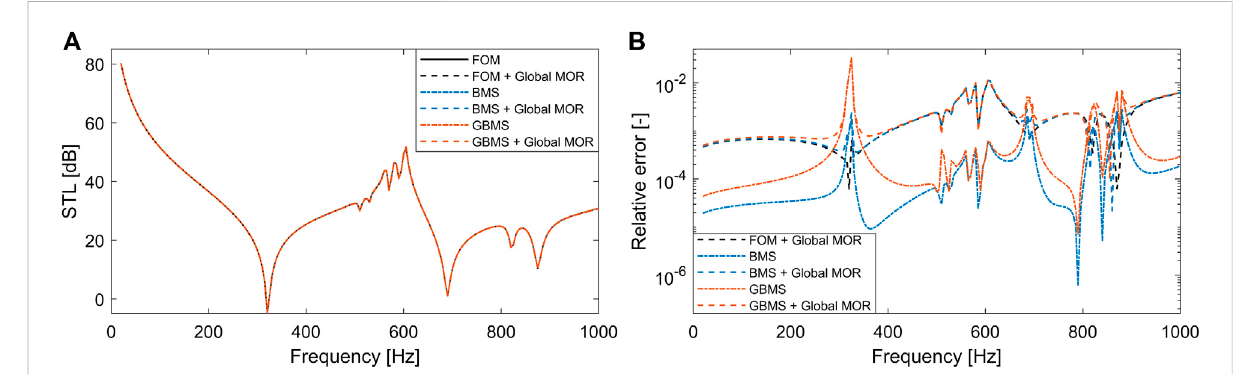
FIGURE 7 STL results (A) and relative error with respect to the FOM (B) computed for the clamped fi nite plate assembly of 5 × 5 UCs for different ROMs. The good agreement between the results causes the STL curves (A) to appear on top of each